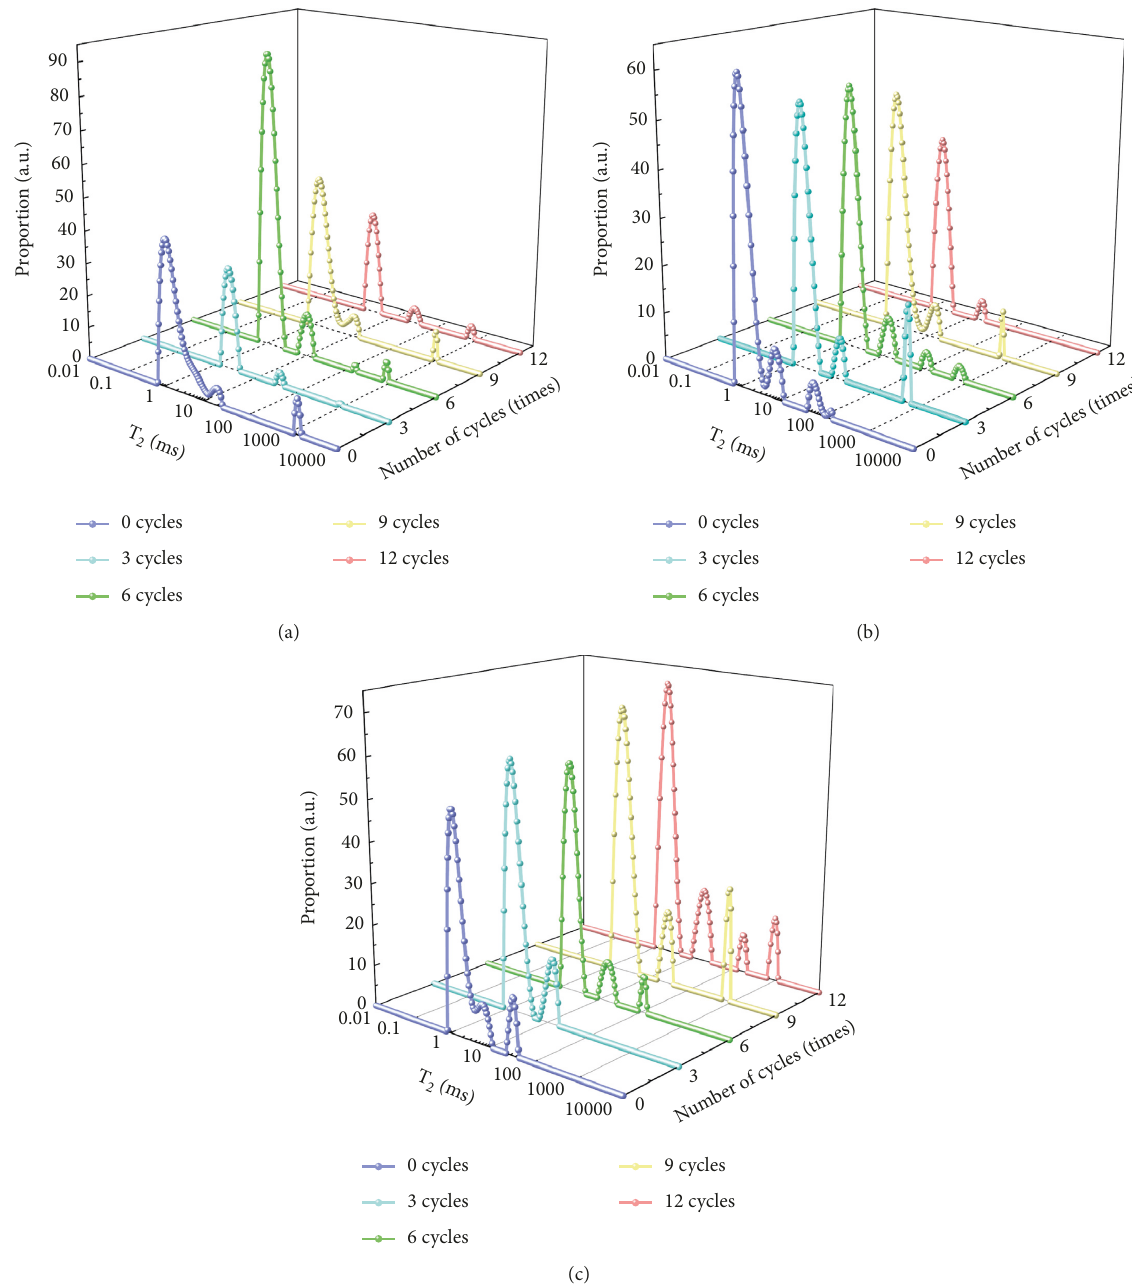
Figure 9: Pore distribution characteristics of semirigid base material after different cycles at different temperature intervals